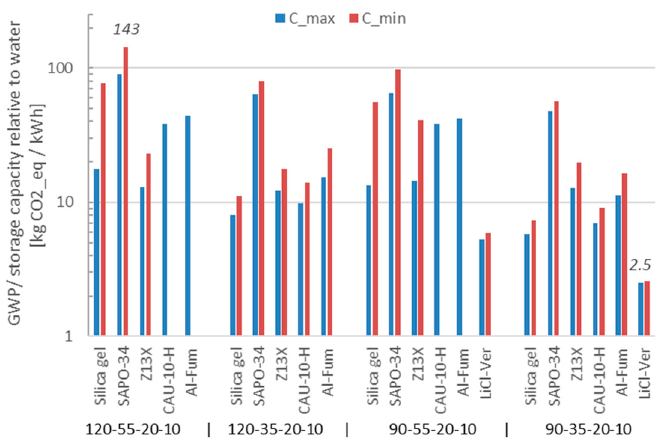
Figure 12. GWP per storage capacity of sorption storages under different boundary conditions (T des - T ads -T cond -T evap ) compared to water.